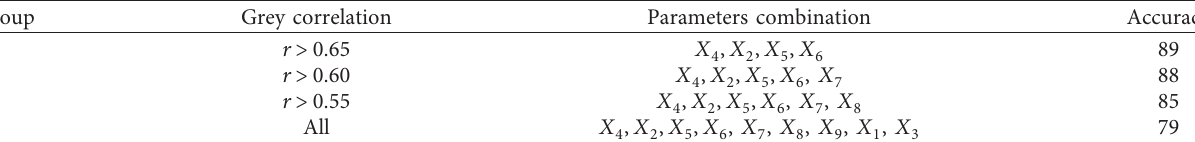
Table 4: Test grouping results.